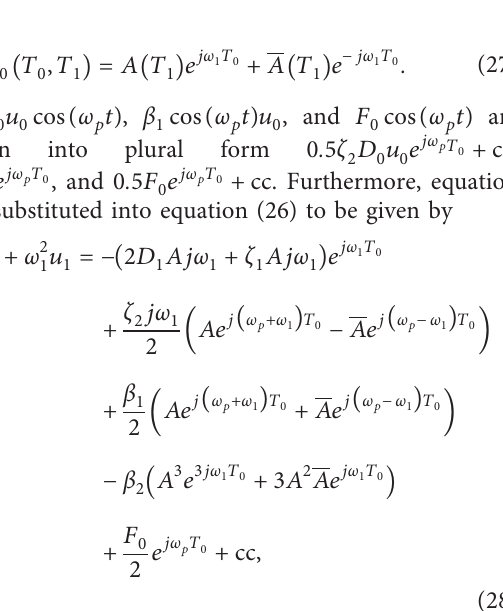
Figure 4: Relationship between dynamic load factor and speed